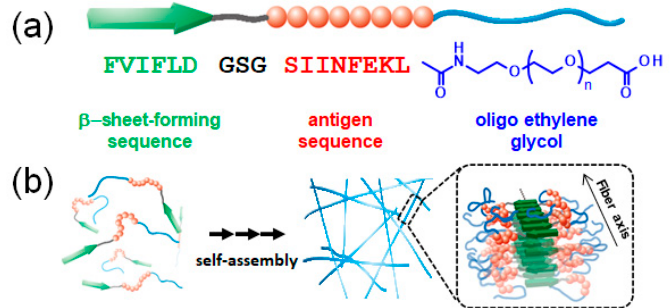
Figure 1. ( a ) Design of the building block peptides (EG n ) composed of a β -sheet-forming sequence (FVIFLD), a flexible-linker block (GSG), a model antigen sequence (SIINFEKL from Ovalbumin), and oligo(ethylene glycol); ( b ) schematic of the self-assembling process for nanofiber formation and the proposed model of highly antigen-loaded nanofibers based on a study previously reported